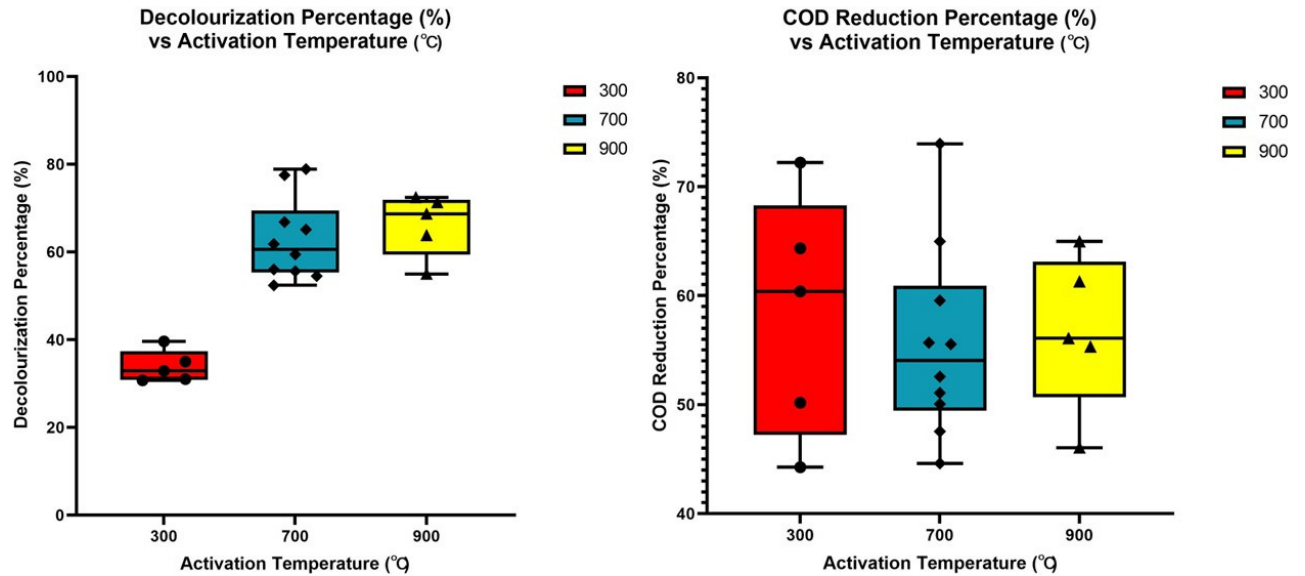
Figure 7. The decolourisation percentages ( left ) and COD reduction percentages ( right ) of STDW based on activation temperature.